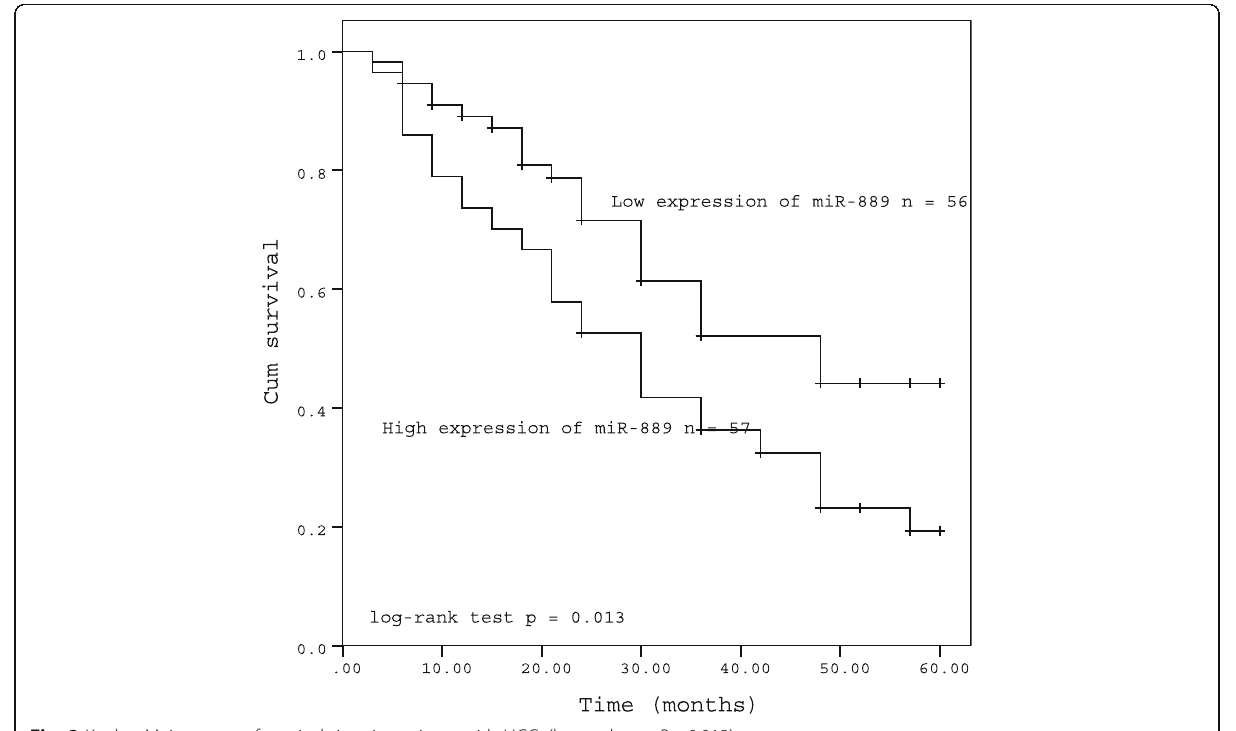
Fig. 2 Kaplan-Meier curve of survival time in patients with HCC. (log-rank test P =